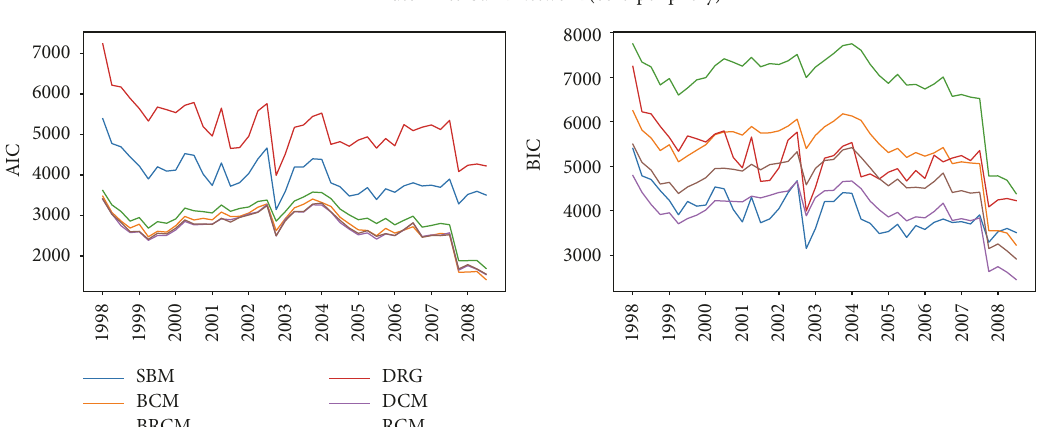
Figure 5: Evolution of the AIC and BIC values for the DIN across the quarters1998Q1-2008Q4: while the SBM (blue trend) must be preferred to the traditional DRG (being the network composed by parts with different link densities), heterogeneous benchmarks are, generally speaking, to be preferred. Although the DCM wins in the vast majority of cases (both for the bow-tie and the core-periphery mesoscale structures), quarters exist where the DCM and the RCM compete; BIC, on the other hand, lets the SBM win sometimes, when analysing the DIN core-periphery structure. The ddc-SBM experiences convergence problems throughout the entire temporal